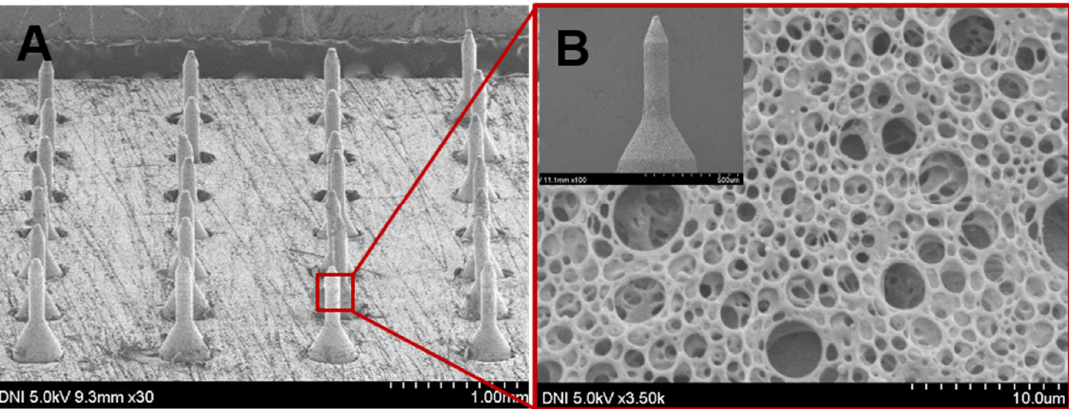
Figure 2. Scanning electron microscopy (SEM) micrographs of the glucose-responsive porous coated